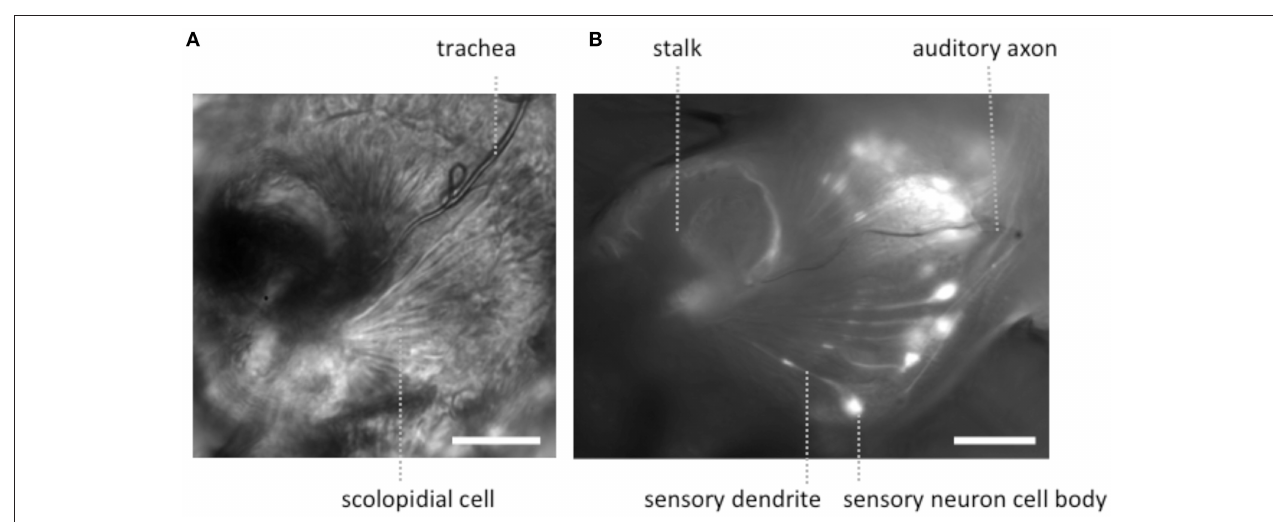
FIGURE 2 | Light microscopic images of JOs within a goggatomized A2. (A) Bright field image of JO (B) fluorescent image of JO expressing GCaMP6. Both specimens have approximately the same orientation. Scale bars 20 µ m.